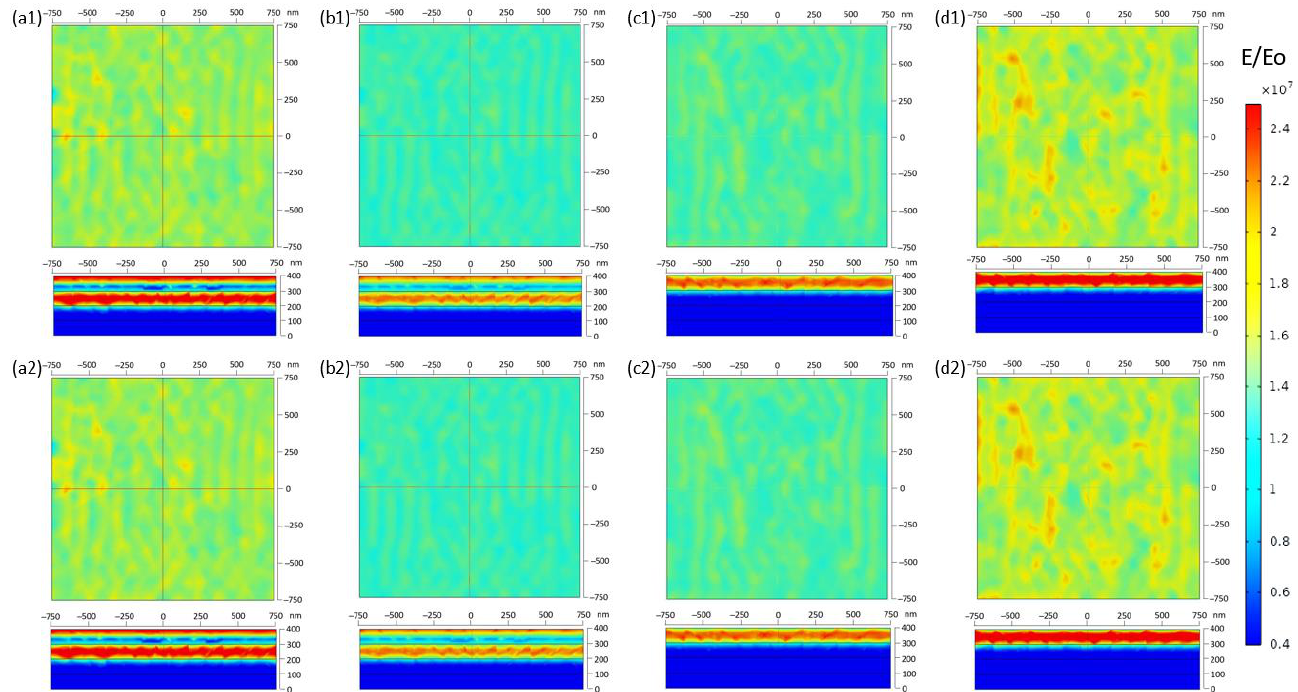
Figure 2. The top view and side view of the electric field distribution simulation on the ( a ) Ag, ( b ) Ag/Au, ( c ) Au, and ( d ) Au/Ag electrodes using the (1) normal and (2) hypoalbumin